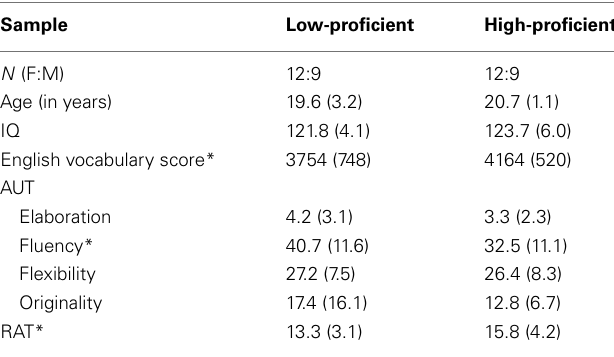
Table 1 | Demographic data measures, vocabulary proficiency scores, originality, fluency, flexibility, and elaboration scores from the alternate uses task (AUT), the number of correct items from the remote associates task (RAT), means, and SD for the low-proficient and high-proficient bilinguals are